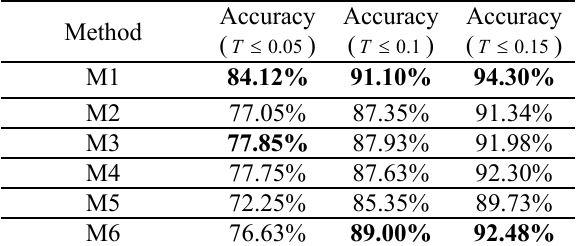
Comparison accuracy versus relative